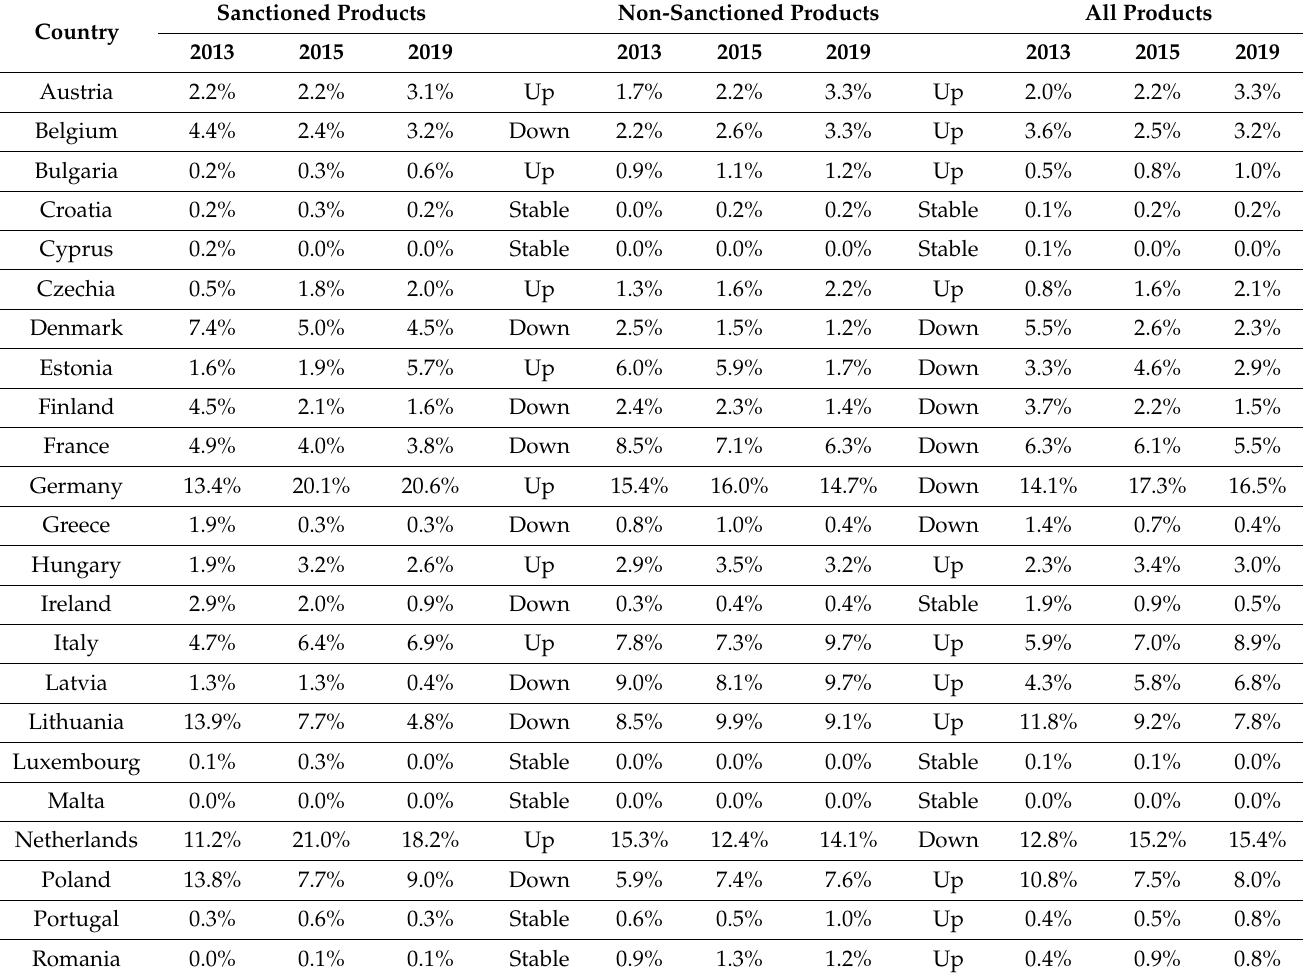
Table 3. Shares of individual countries in EU28 agri-food trade with Russia. Source: Authors’ own calculations based on UN COMTRADE